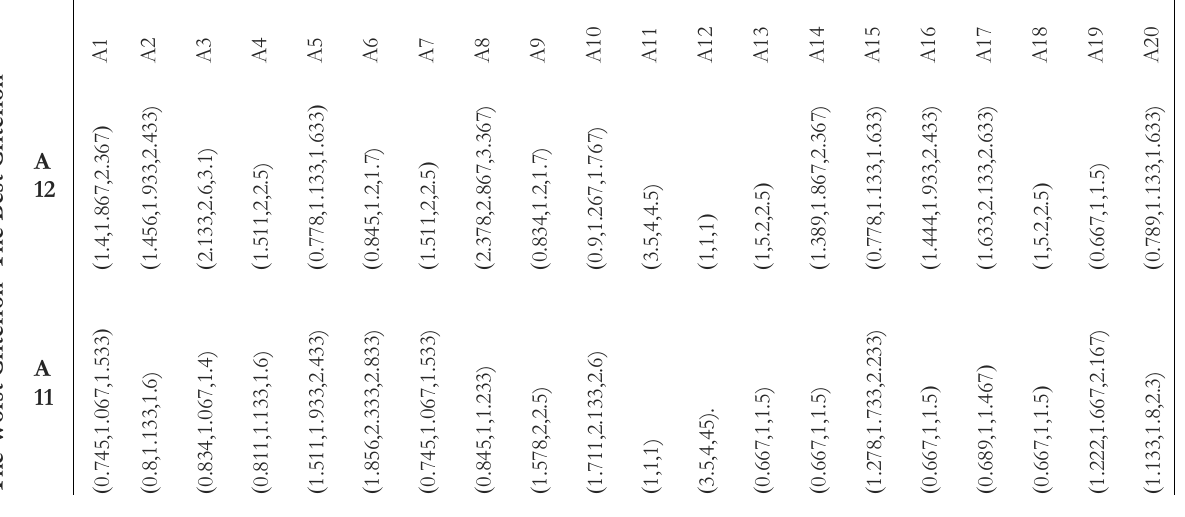
Table 5. Pairwise comparison of legal sub-criteria.